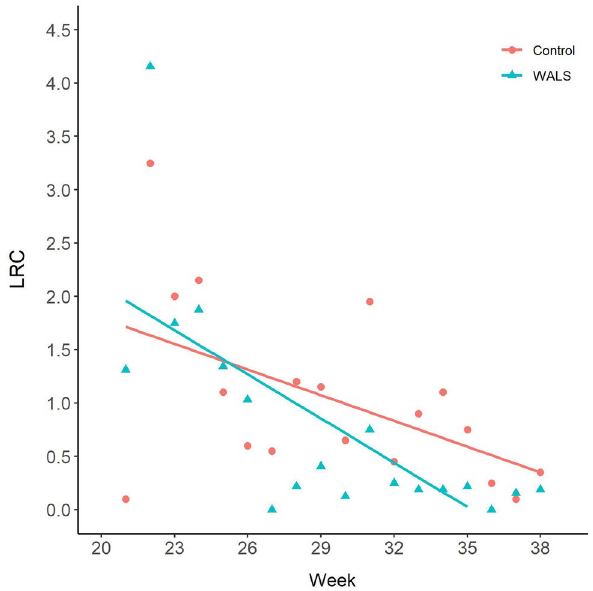
Fig. 10 Average number of females collected (Landing Rate Count, LRC) for each week in untreated control and WALS sites